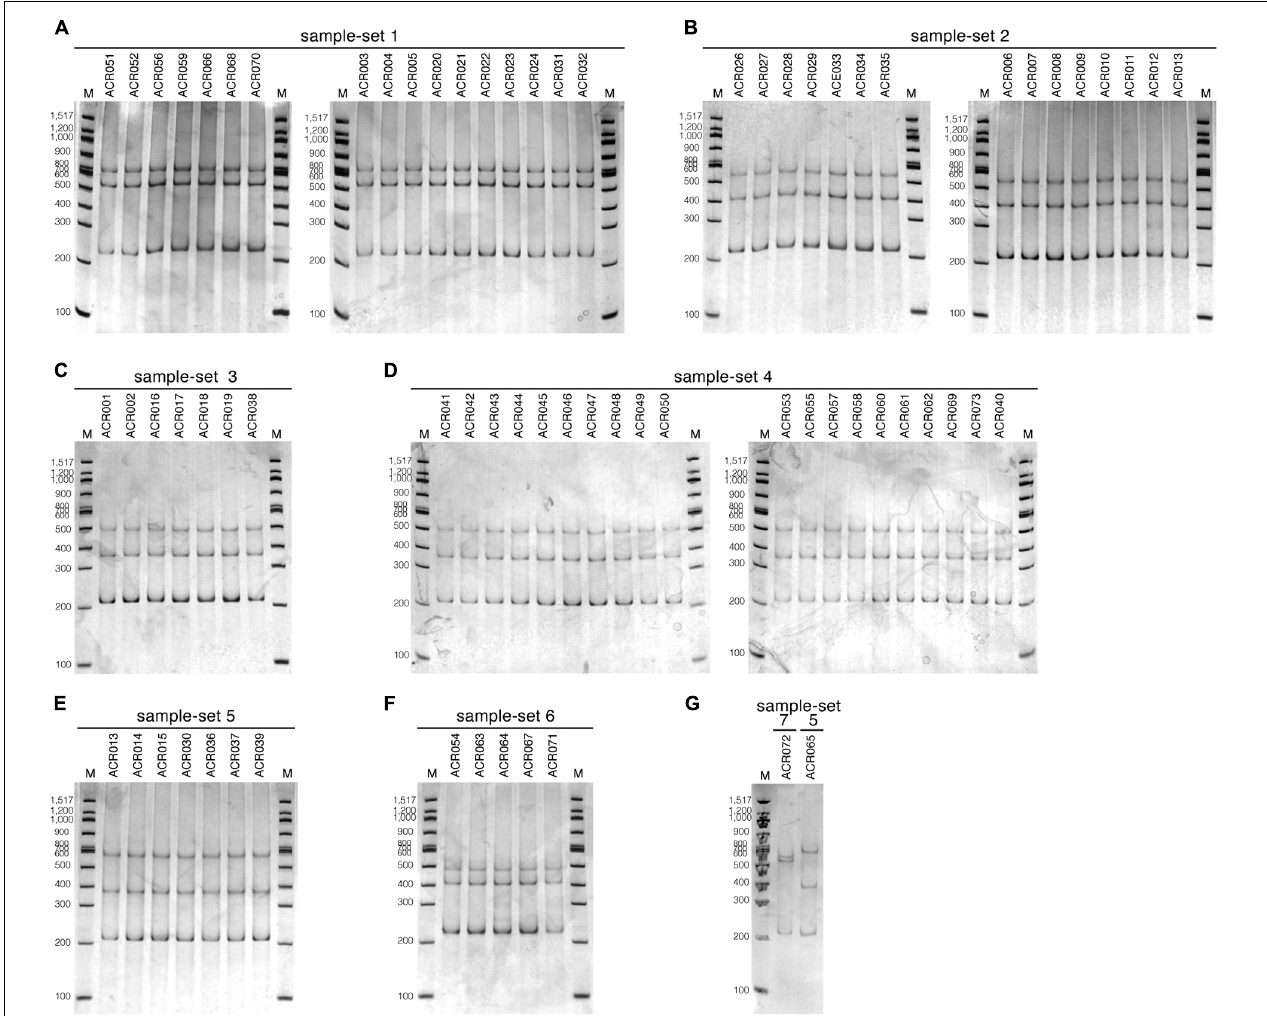
FIGURE 4 | The single-strand conformation polymorphism (SSCP) fingerprint patterns of all 73 dictyostelid Thai isolates used in this study. The SSCP fingerprints were run in 9% polyacrylamide gel electrophoresis (PAGE) under the electrophoretic condition at 130 V, 4 ◦ C for 3 h, followed by the silver staining. The 100-bp DNA ladder (New England Biolab, United States) was used as the DNA markers for all PAGE gels (lane M). The SSCP fingerprint pattern of each sample-set is illustrated in separate panels, including sample-set 1 (A) , sample-set 2 (B) , sample-set 3 (C) , sample-set 4 (D) , sample-set 5 (E,G) , sample-set 6 (F) , and sample-set 7 (G) .